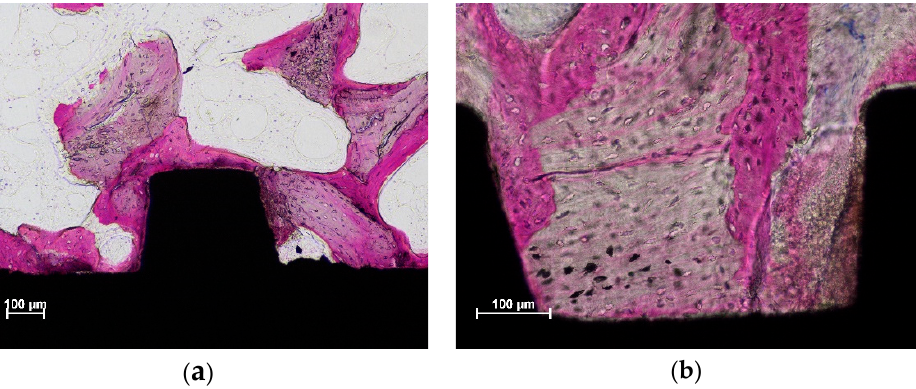
Figure 5. Graft particles (light purple) included into newly-formed bone (dark purple) and in contact with the implant surface in both figures ( a , b ). Acid fuchsine and toluidine blue stain.